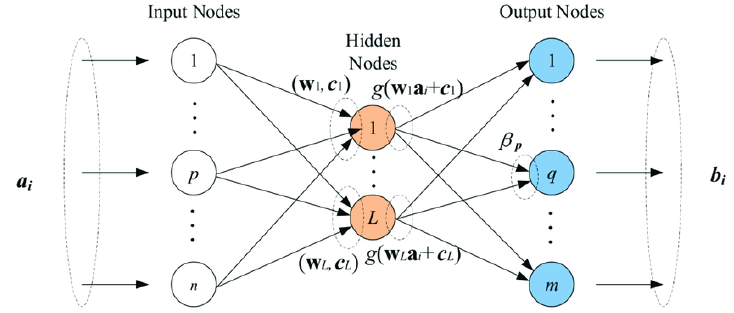
Figure 8. ELM diagram.